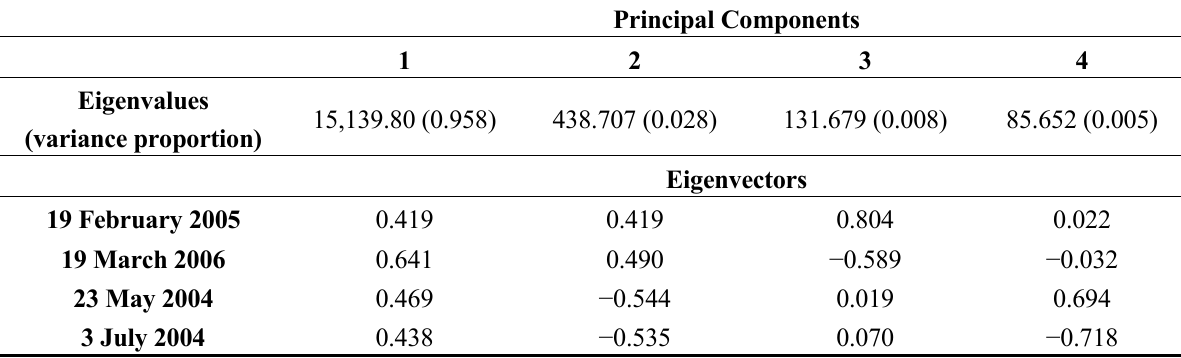
Table 3. Eigenvalues and eigenvectors for time series Principal components analysis (PCA) for differentiation of water masses.